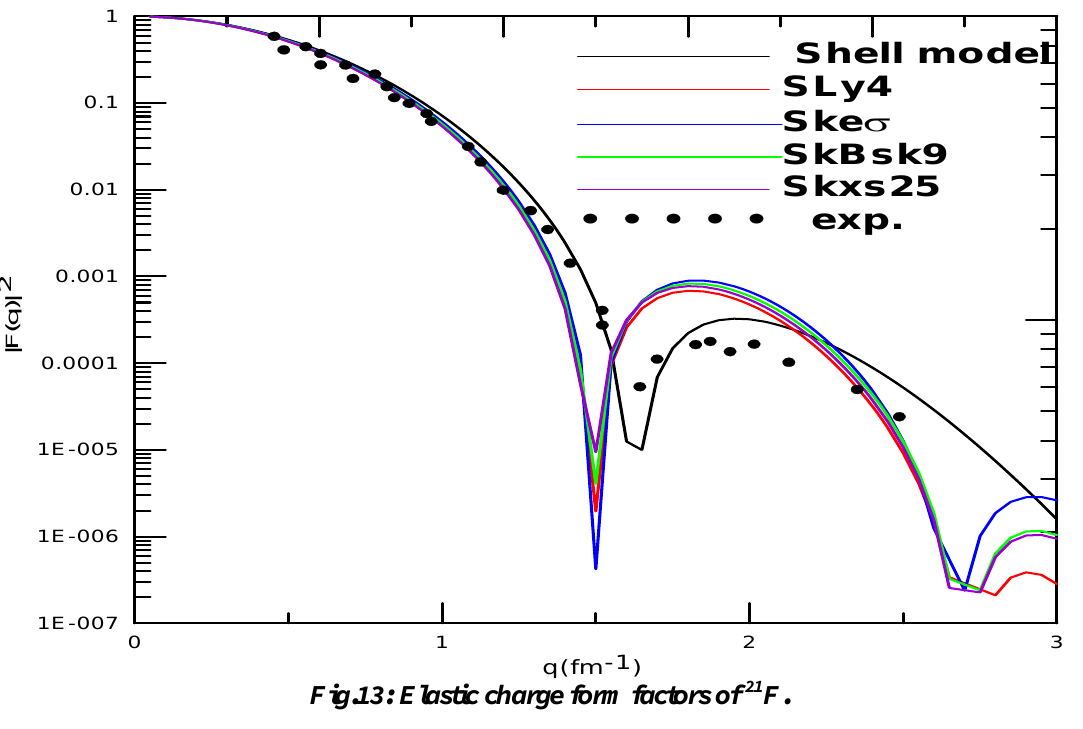
Fig.13: Elastic charge form factors of 21